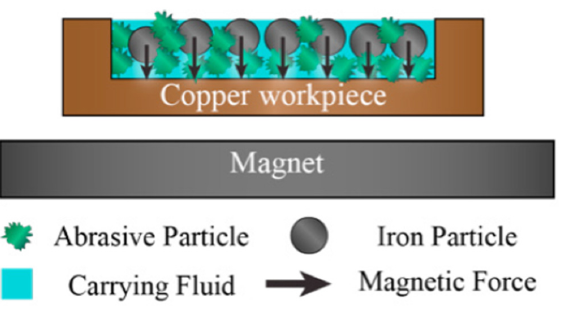
Figure 19. Performance comparison of different parts. Adapted from [116] Elsevier, 2018.